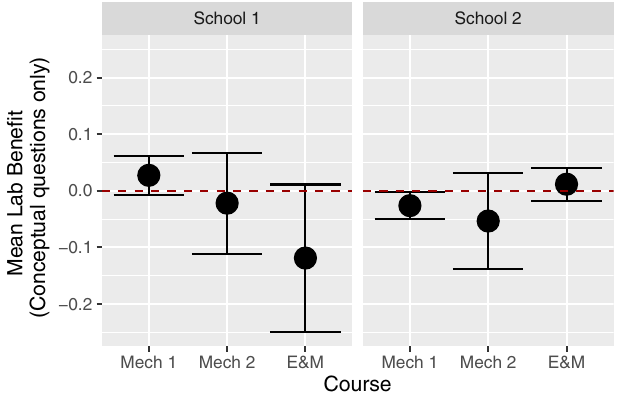
FIG. 2. The mean conceptual lab benefit [Eq. (2)] for six courses at two institutions. Error bars represent the standard error (= standard uncertainty in the mean). The dashed line indicates the hypothesis being tested (whether the mean lab benefit differs significantly from 0).